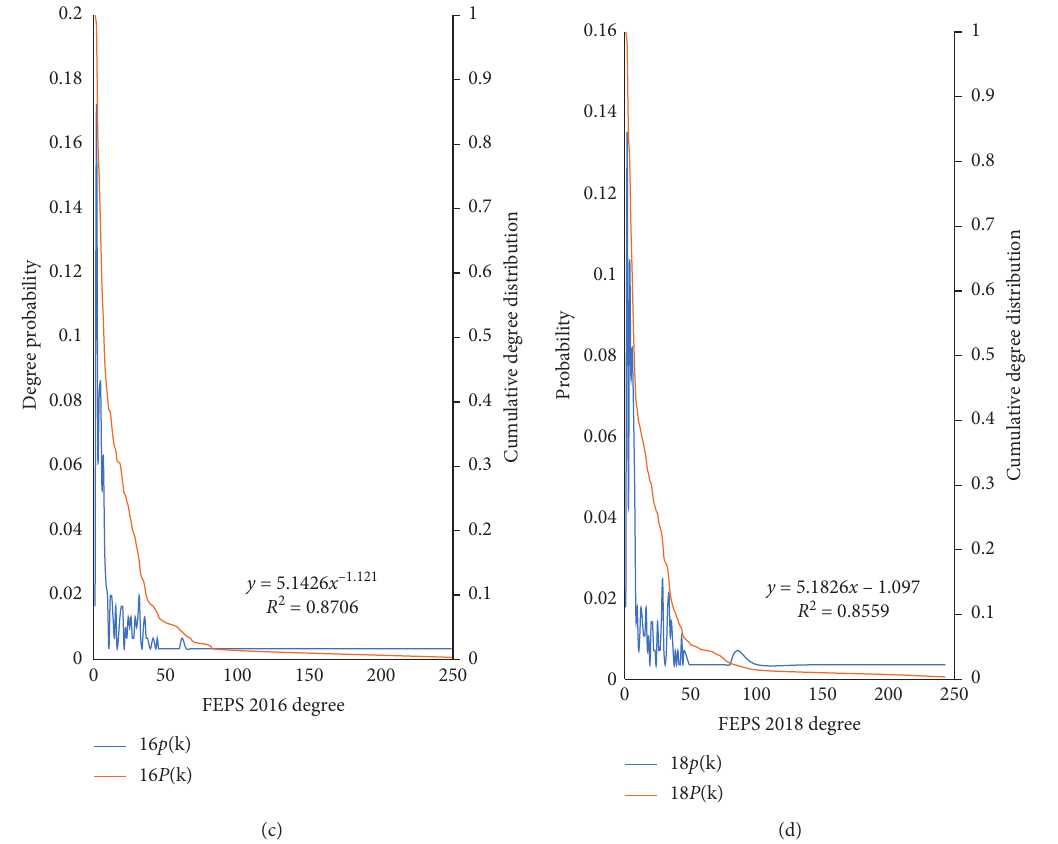
Figure 2: Cumulative degree distribution of the FEPS network in 2008, 2011, 2016, and